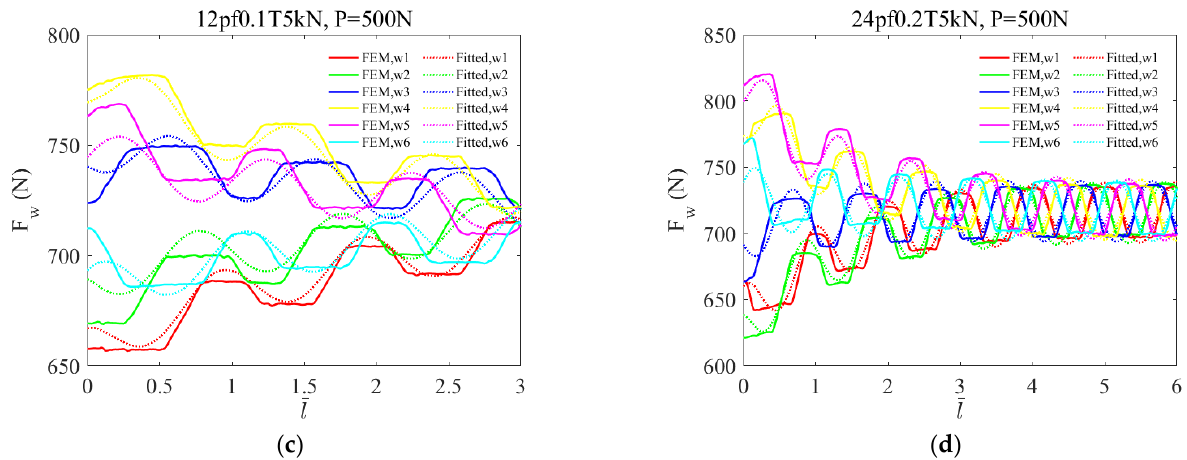
Figure 21. ( a ) The comparison of fitted results and simulation results of the component of force r i along the longitudinal axis for the 12-pitch strand in condition where μ = 0.1, T = 5 kN and P = 500 N and ( b ) for the 24-pitch-long strand in condition where μ = 0.2, T = 5 kN and P = 500 N; ( c ) The comparison of fitted results and simulation results of the axial tension force of each outer layer wire along the longitudinal axis for the 12-pitch-long strand in condition where μ = 0.1, T = 5 kN and P = 500 N and ( d ) for the 24-pitch-long strand in condition where μ = 0.2, T = 5 kN and P = 500 N.